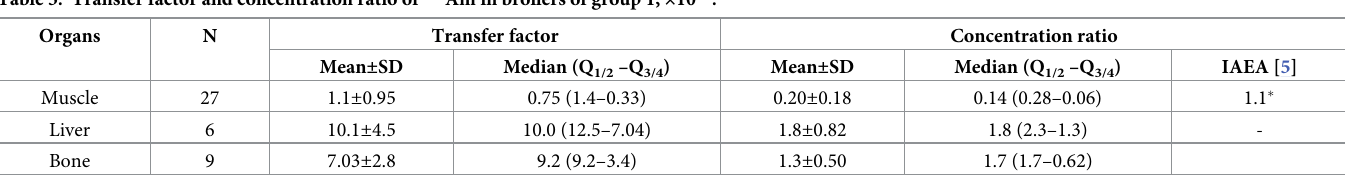
Table 5. Transfer factor and concentration ratio of 241 Am in broilers of group 1, × 10 − 4 .